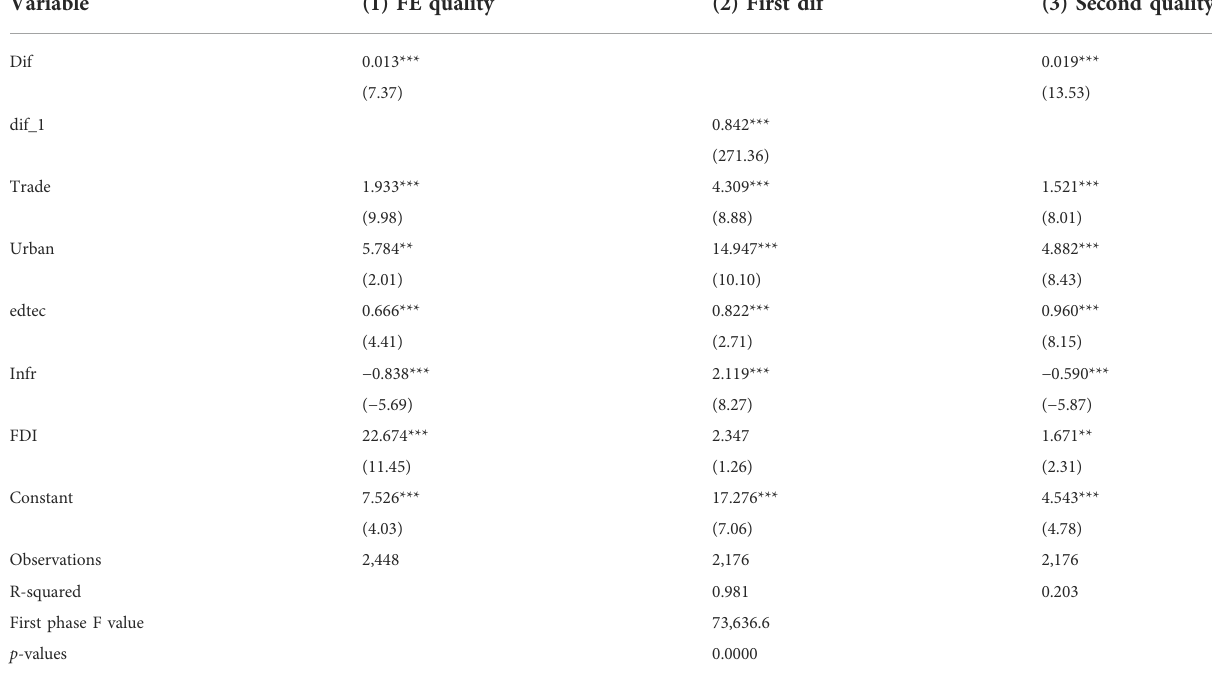
TABLE 3 Baseline regression results of digital fi nance to the quality of economic growth.